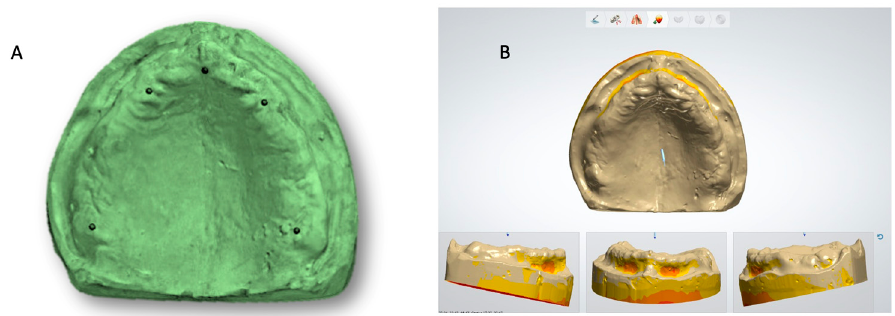
Figure 1. ( A ) Master cast for fabrication of metal master model; ( B ) Representative scanned images of master cast.